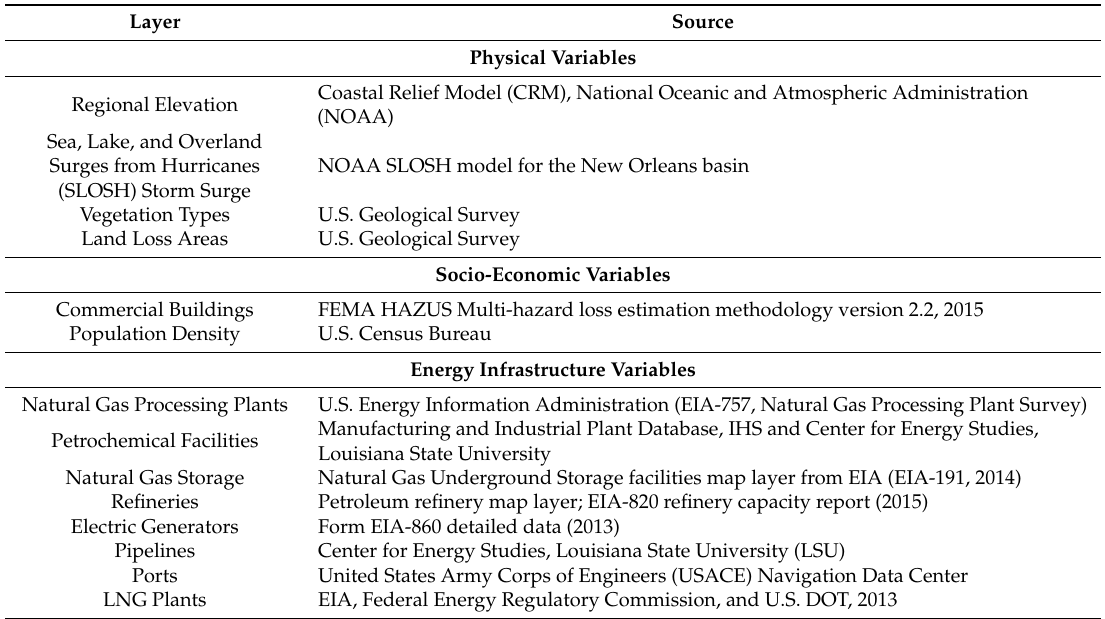
Table 2. Data layers and sources for infrastructure, physical and socio-economic variables included in the Coastal Infrastructure Vulnerability Index (CIVI) for coastal